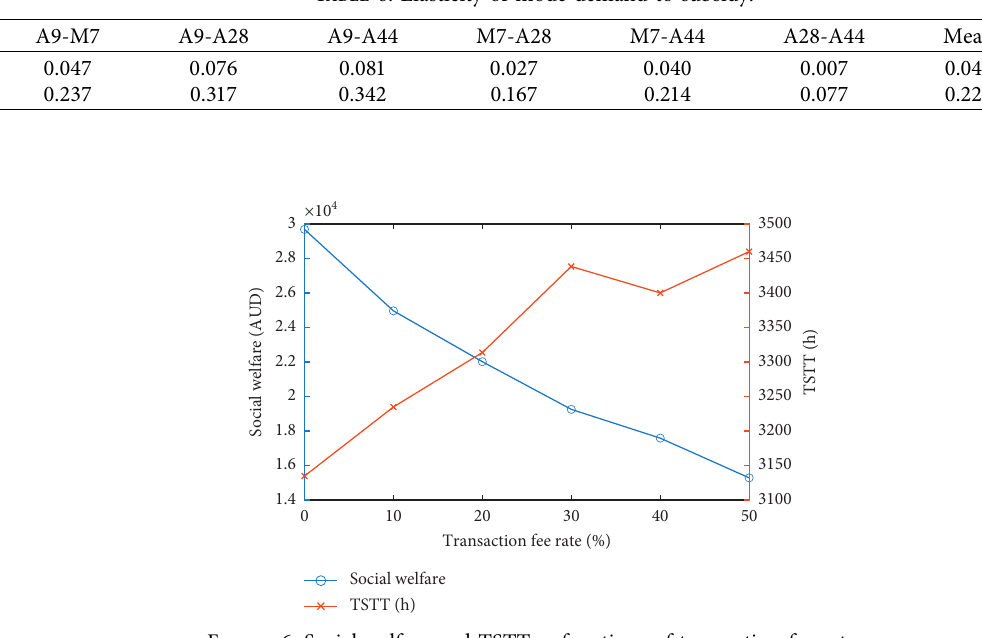
Figure 5: Subsidy allocated as a function of subsidy. Table 6: Elasticity of mode demand to subsidy.